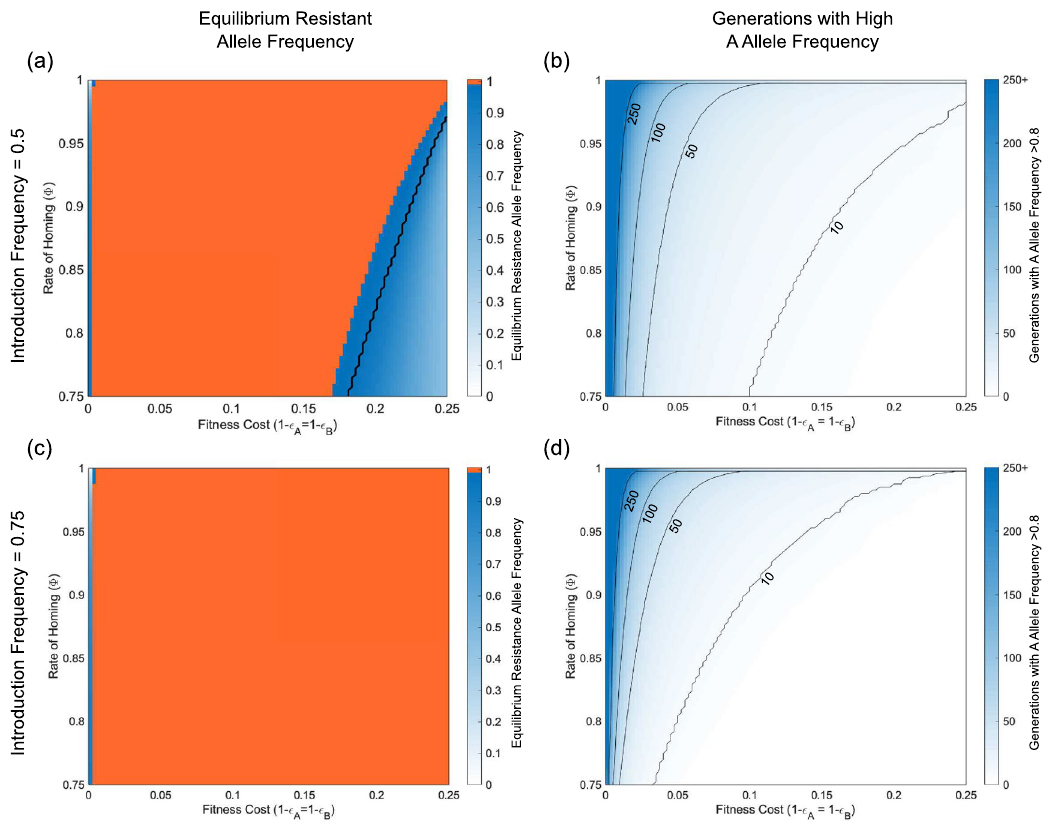
Figure 5. NHEJ leads to the breakdown of SDKR where resistant alleles are of higher fitness than transgenic constructs. Results of numerical simulations using an initial release frequency of ( a , b ) 0.5 or ( c , d ) 0.75 over a discretised parameter grid. Here, panels ( a , c ) show the equilibrium resistance allele frequency (taken after 2000 generations). Orange areas represent the region in which the equilibrium resistant allele frequency equals one. Blue regions (with values shown in colour bars) denote regions in which the equilibrium resistant allele frequency was less than one. In panel ( a ) the region below the black line is that in which the SDKR system fails to increase above its initial release frequency. In the area between the orange region and the yellow line, the drive initially increases in frequency but is then eradicated before the resistant allele frequency has time to reach fixation. Panels ( b , d ) show the number of generations in which the A allele frequency is above 0.8. In each case, it is assumed that DSBs are induced in 95% of eligible target sequences with the repair mechanism